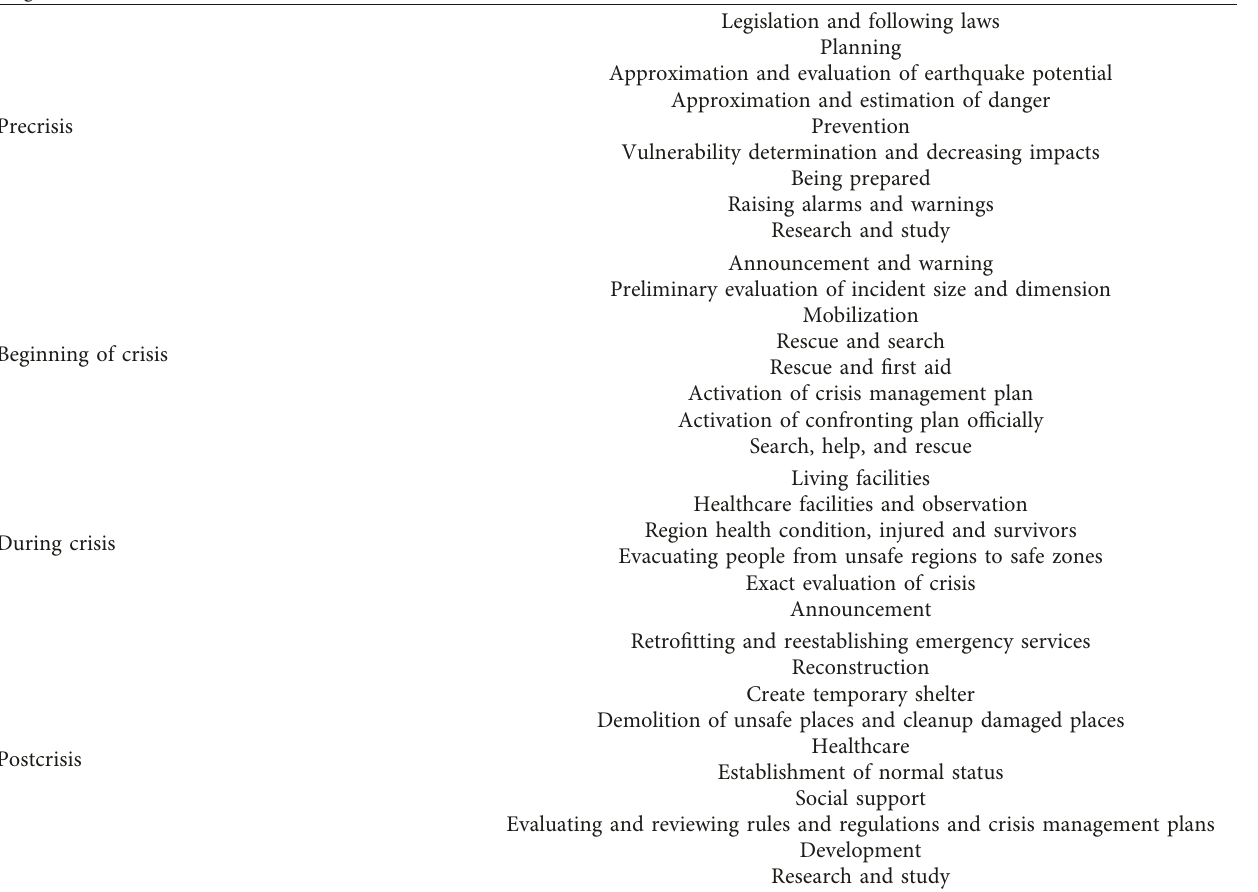
Table 2: Management activities in different stages of crisis management cycle.